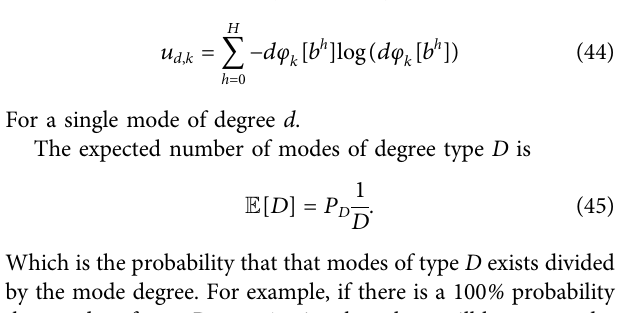
Algorithm 1 takes a single mode and calculates the probability of existence for each of its children P child using Eq. 42 . The P D for the mode degree type D of the children is incremented in line 6 by combining P child with the probability of the fi rst parent P init and normalizing by the mode ’ s degree. The algorithm then returns the P D for the modes processed as well as a list of the child modes appended to the unprocessed modes list. Algorithm 2 recursively calculates the probability P D that each mode degree type D exists across a given duration. It calculates all unprocessed modes and inputs the ones that are born before time T Q into Algorithm 1. The unprocessed modes returned from Algorithm 1 are appended to the unprocessed mode list. This recursion repeats until there are no remaining unprocessed modes within the desired time window. Algorithm 2 ensures each possible mode is passed into Algorithm 1 and Algorithm 1 calculates the mode ’ s P D . Therefore, Algorithm 2 provides the probability of P D for each mode degree type D over a set duration T Q .